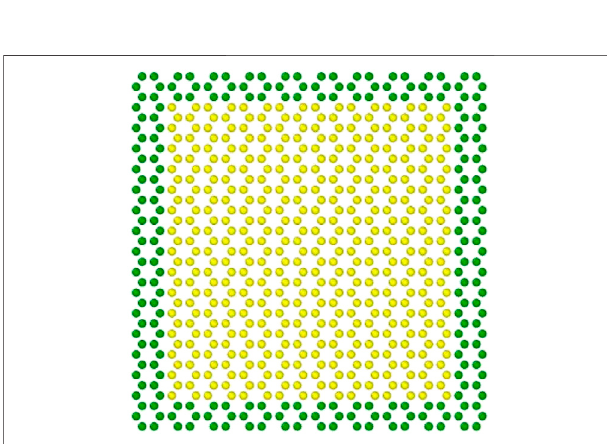
FIGURE 10 | Schematic diagram of the edge (green) and inner (yellow) areas of the